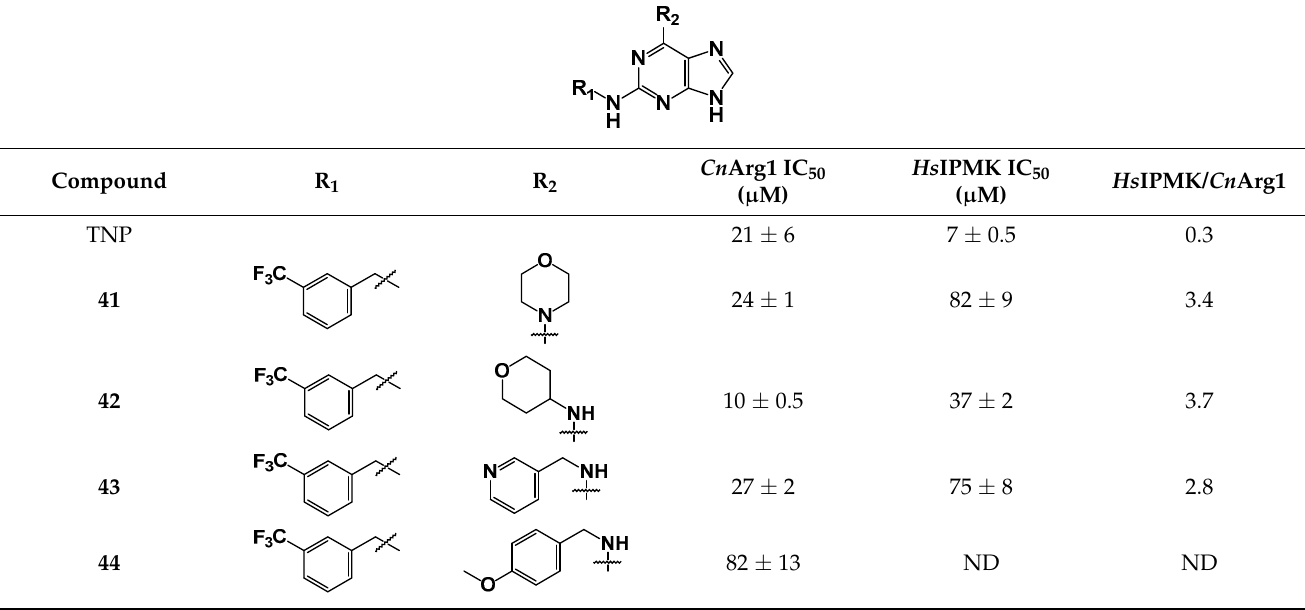
Table 5. Summary of inhibitory properties resulting from chemical exploration at both the R 1 and R 2 positions on the TNP purine core . Only potent and soluble analogues with an IC 50 < 40 µM for Cn Arg1 were tested for inhibitory properties against Hs IPMK. ND = not determined.